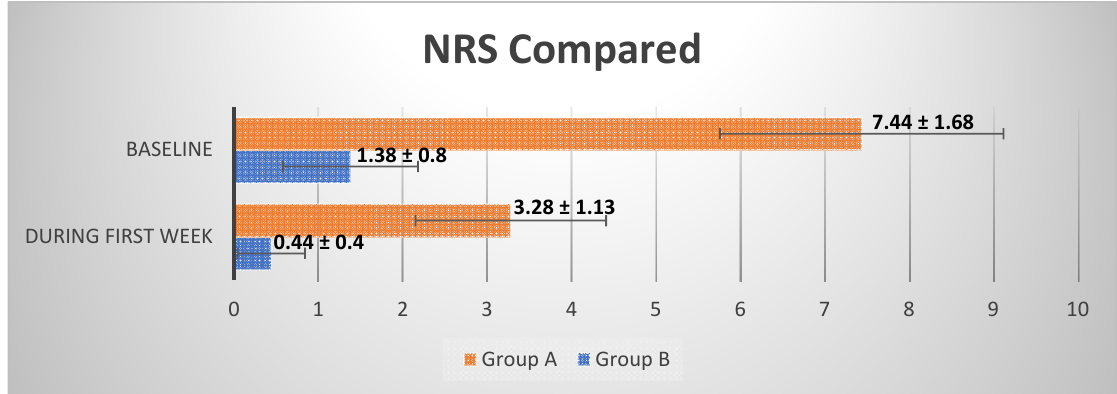
Figure 15. Comparison between the average NRS ± SD recorded at baseline and during the first week after surgery in Groups A and B.